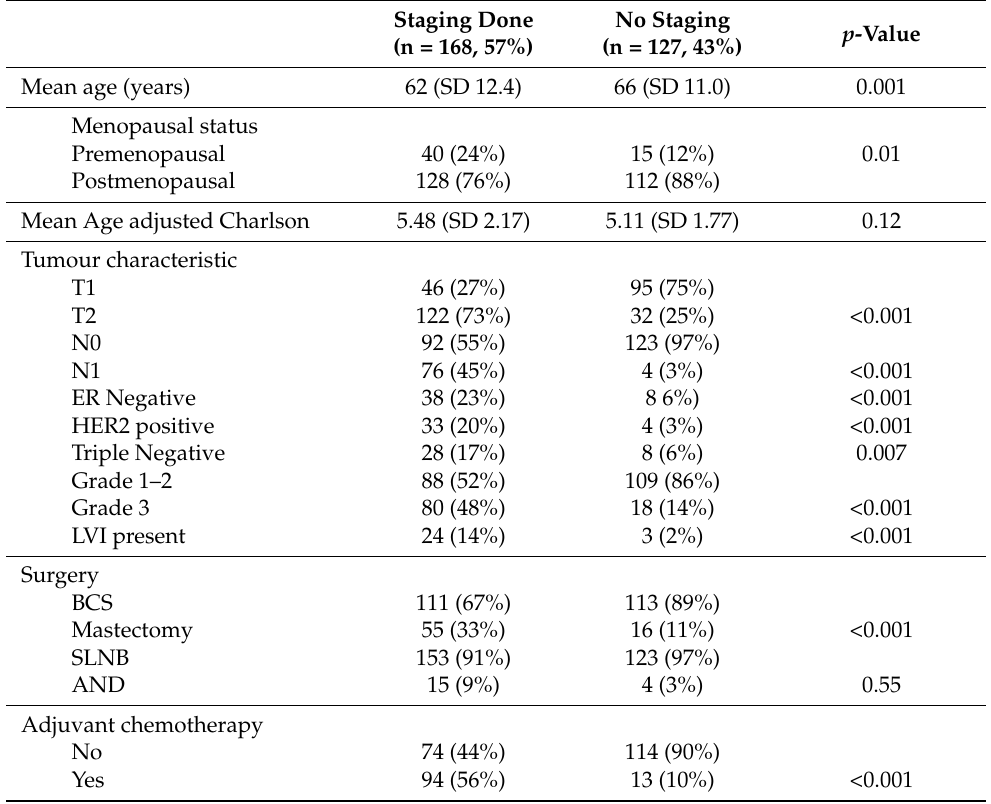
Table 4. The association between baseline staging investigations and patient demographics, and tumour and treatment